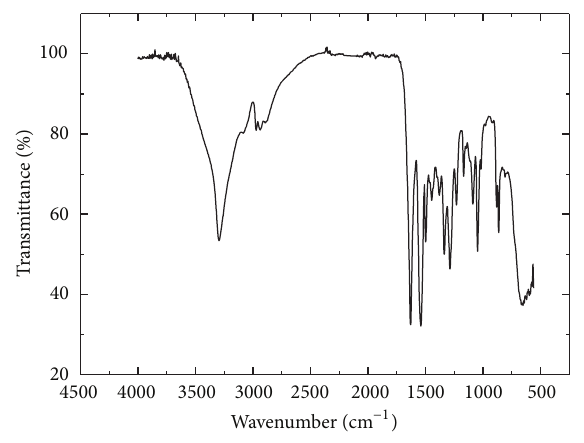
Figure 7: IR spectra of microcapsules with TiO 2 prepared by interfacial polymerization.